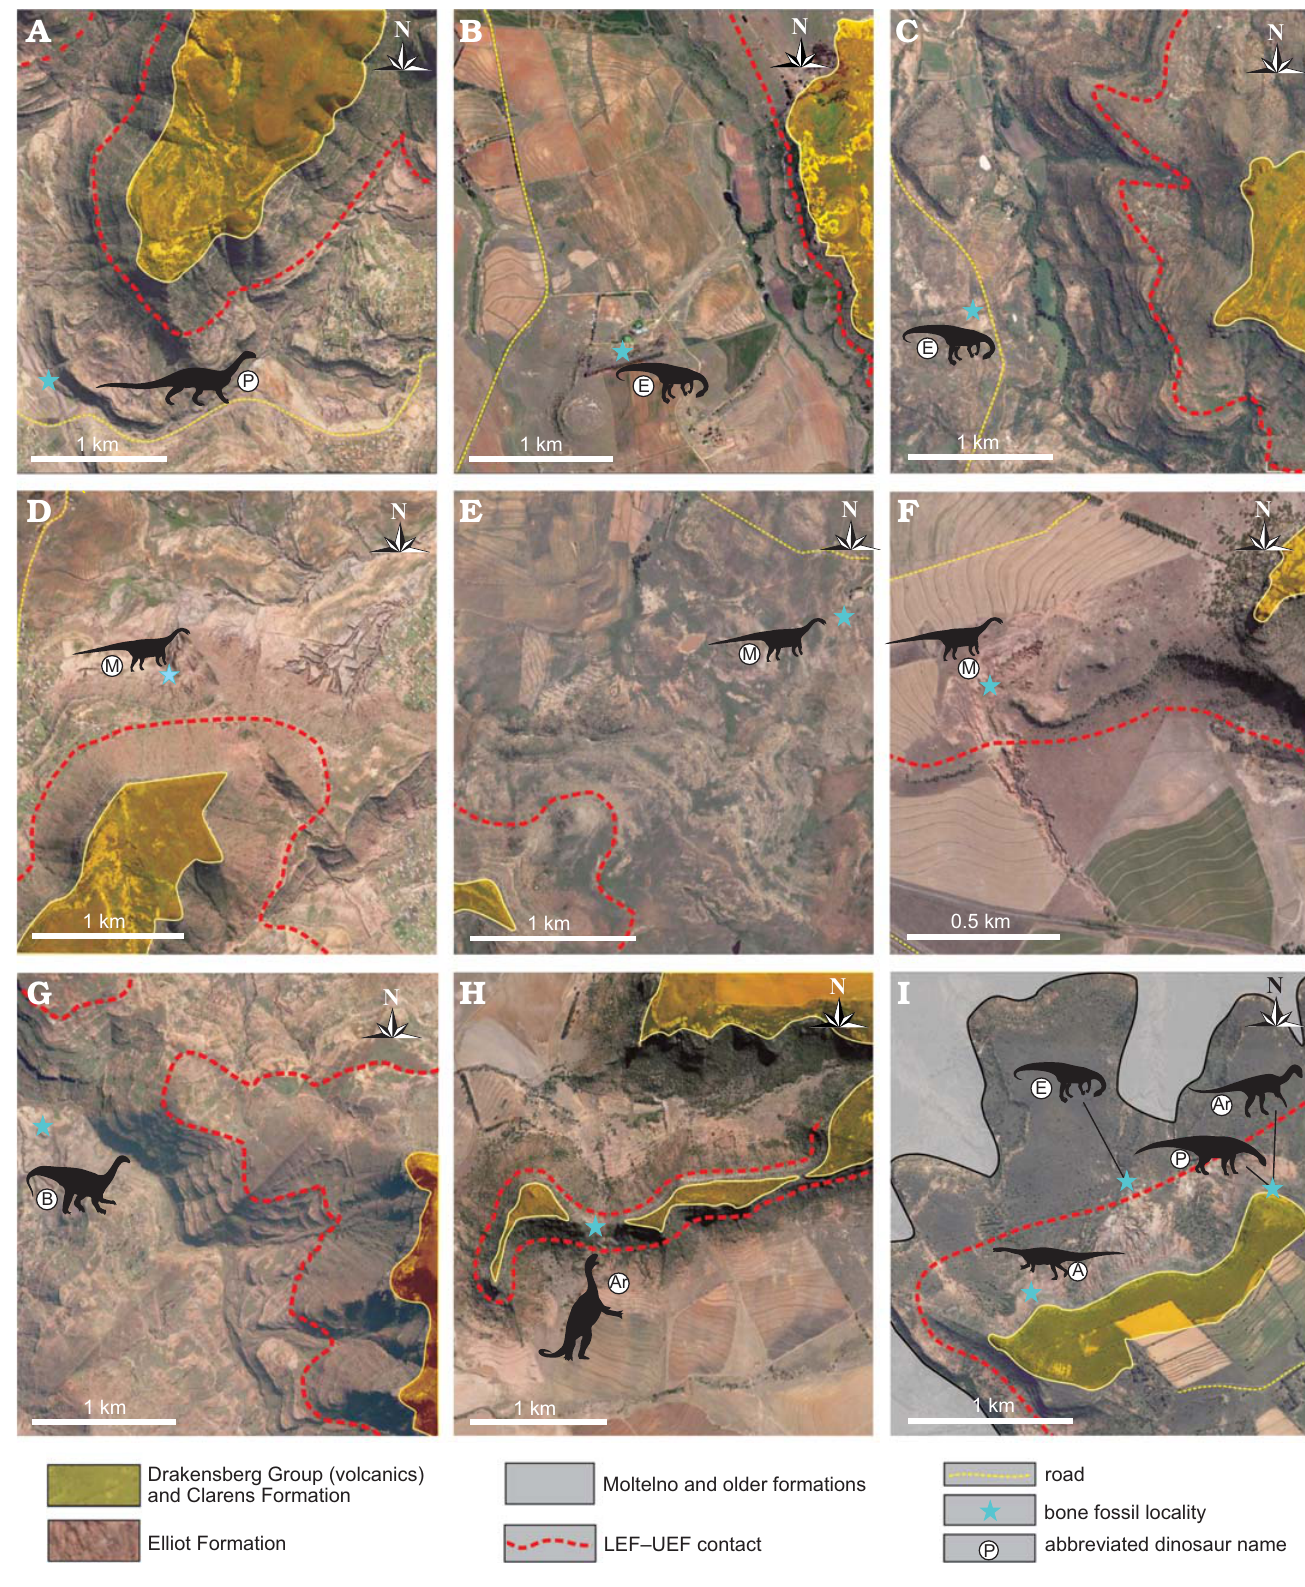
Fig. 2. Geological maps of the key sauropodomorph specimen localities discussed in the text. See Table 1 and Fig. 3 for GPS coordinates and details on stratigraphic positions, respectively. A . Kromme Spruit, ~6 km ESE of Sterkspruit, Eastern Cape Province (3027CB); the type locality of Plateosauravus cullingworthi . B . Zonderhout 291 Farm, ~108 km NE of Ladybrand, eastern Free State Province (2828AC); the type locality of Eucnemesaurus fortis . C . Cannon Rock (270) Farm, ~60 km SE of Sterkspruit, Eastern Cape Province (3127AA); the type locality of Eucnemesaurus entaxonis . D . Thaba ’Nyama,